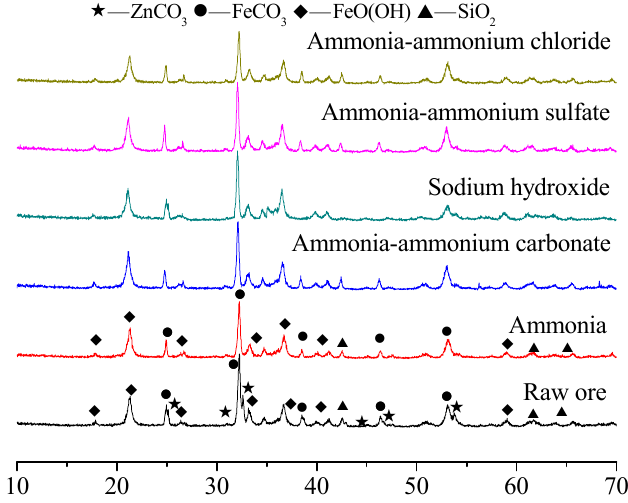
Figure 3. XRD patterns of the leaching products by different lixiviants.